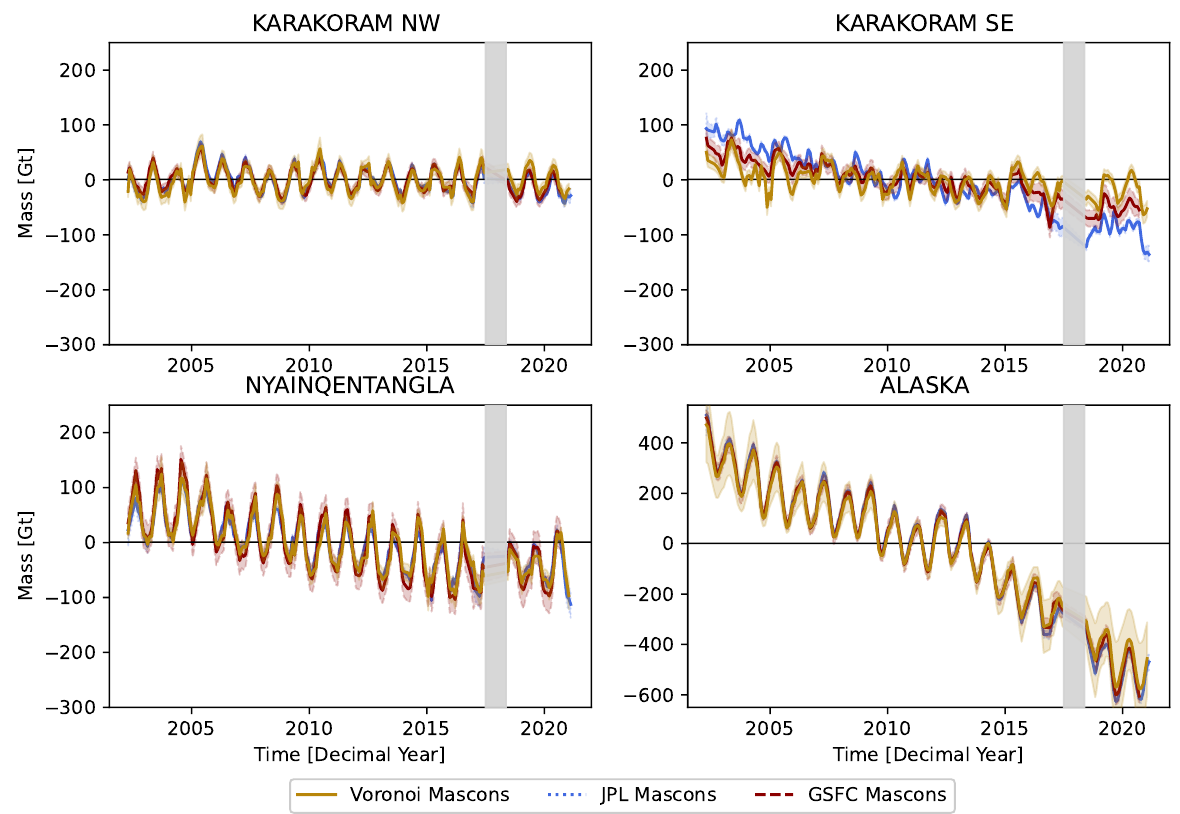
Figure 5. Time series Voronoi (dark beige), JPL (blue) and GSFC (dark red) mascons shown in Figure 4. All solutions use the ICE6G-D GIA correction [36]. The gray vertical bar shows the gap period between the GRACE and GRACE Follow-On missions. Note the difference in the vertical scale for